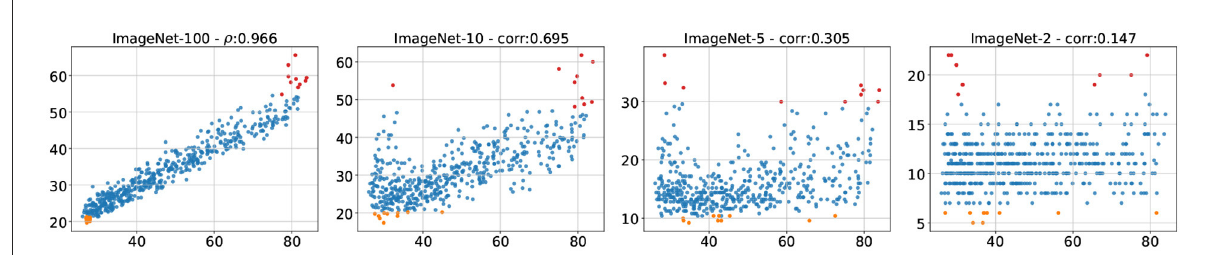
FIGURE4 Error of all 500 sampled architectures on subsampled (by number of classes) versions of ImageNet (y-axis) plotted against the error of the same architectures on regular ImageNet (x-axis). The top 10 performances on the target dataset are plotted in orange and the worst 10 performances in